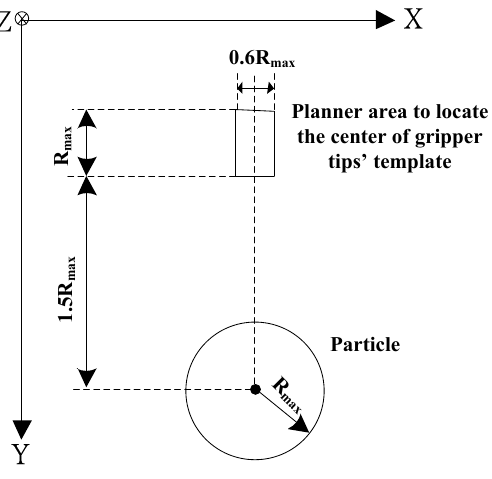
Figure 12. Planner area to locate the gripper by the center of gripper tips’ template in pre-positioning Figure 12. operation.